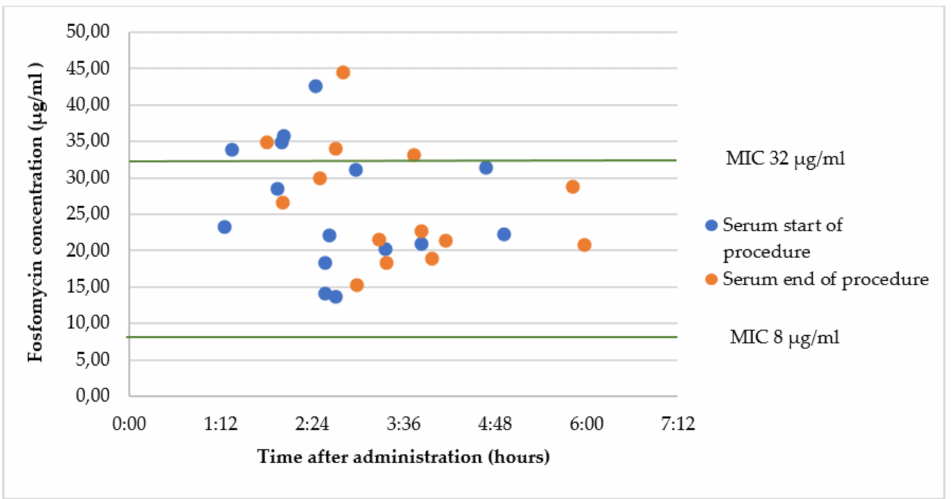
Figure 4. Fosfomycin concentrations in serum after a single oral dose 2 h prior to surgery. E. coli is con- sidered susceptible to oral fosfomycin for treatment of urinary tract infection when MIC < 8 µ g/mL and Enterobacterales are considered susceptible to oral fosfomycin when MIC < 32 µ g/mL